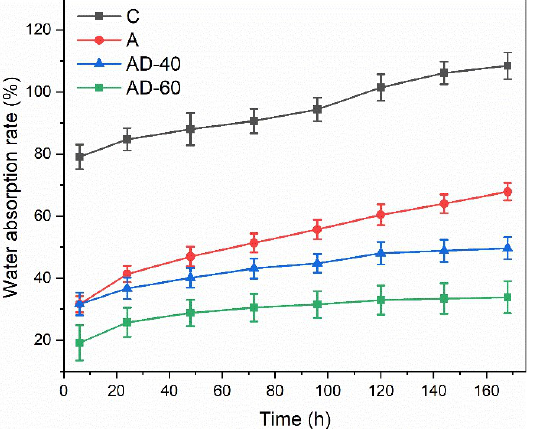
Figure 3. Water adsorption rate of wood samples as a function of